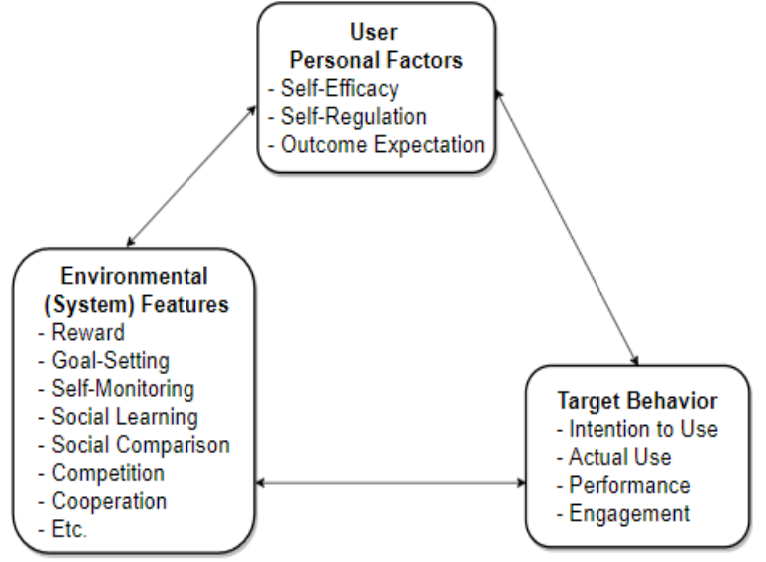
Figure 2. Social cognitive model of reciprocal determinism in persuasive technology context [23].